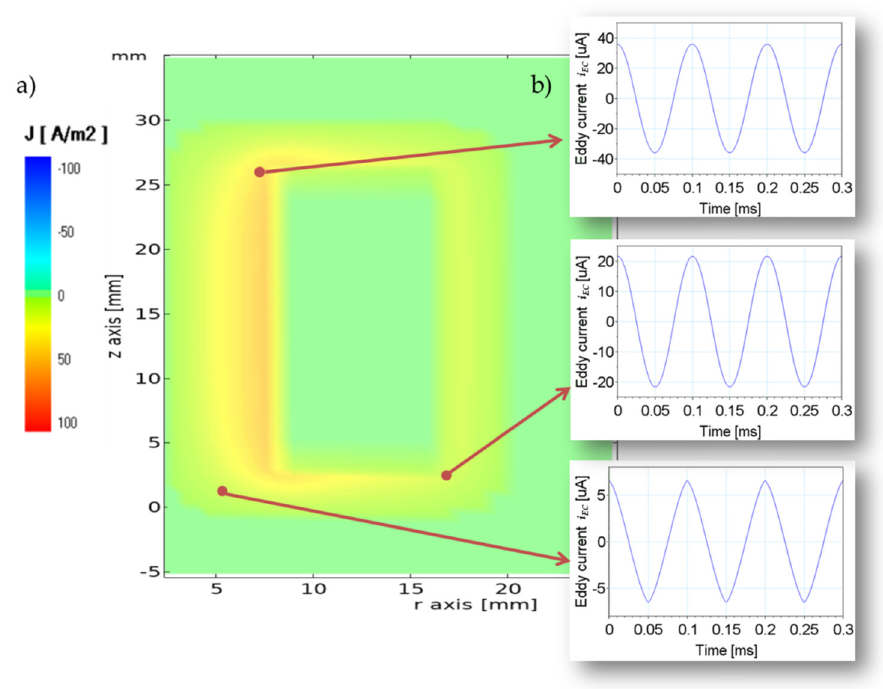
Figure 11. Distribution of the eddy current density in the ferrite core for time t = 100 us ( a ) and the waveforms of the eddy currents i EC for three selected points of ferrite core ( b ) for a frequency of 1 kHz.